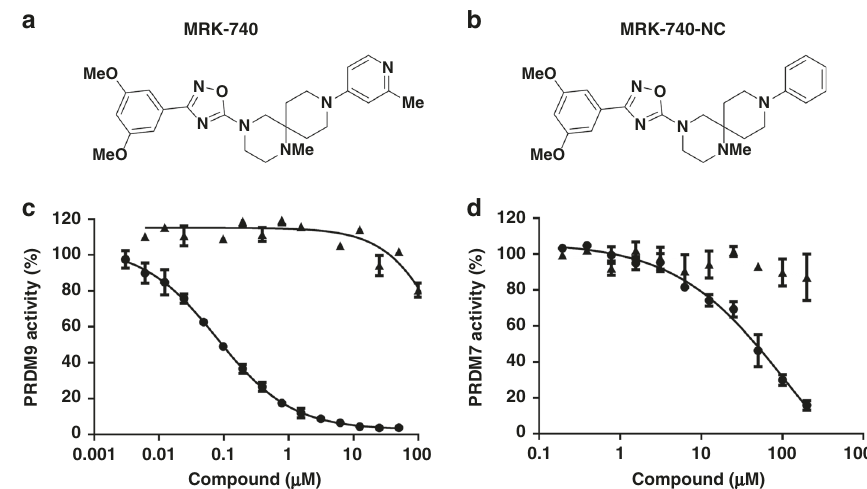
Fig. 1 PRDM9 inhibition by MRK-740. Chemical structures of ( a ) MRK-740 and ( b ) MRK-740-NC are presented. Inhibitory effect of (circle) MRK-740 and (triangle) MRK-740-NC on the methyltransferase activity of ( c ) PRDM9 and ( d ) PRDM7 were evaluated. Experiments were performed in triplicate using biotinylated H3 (1 – 25) peptide as a substrate as described in Methods. Data points are the average ± standard deviation from a minimum of three repeats ( n = 3). Source data are provided as a Source Data fi